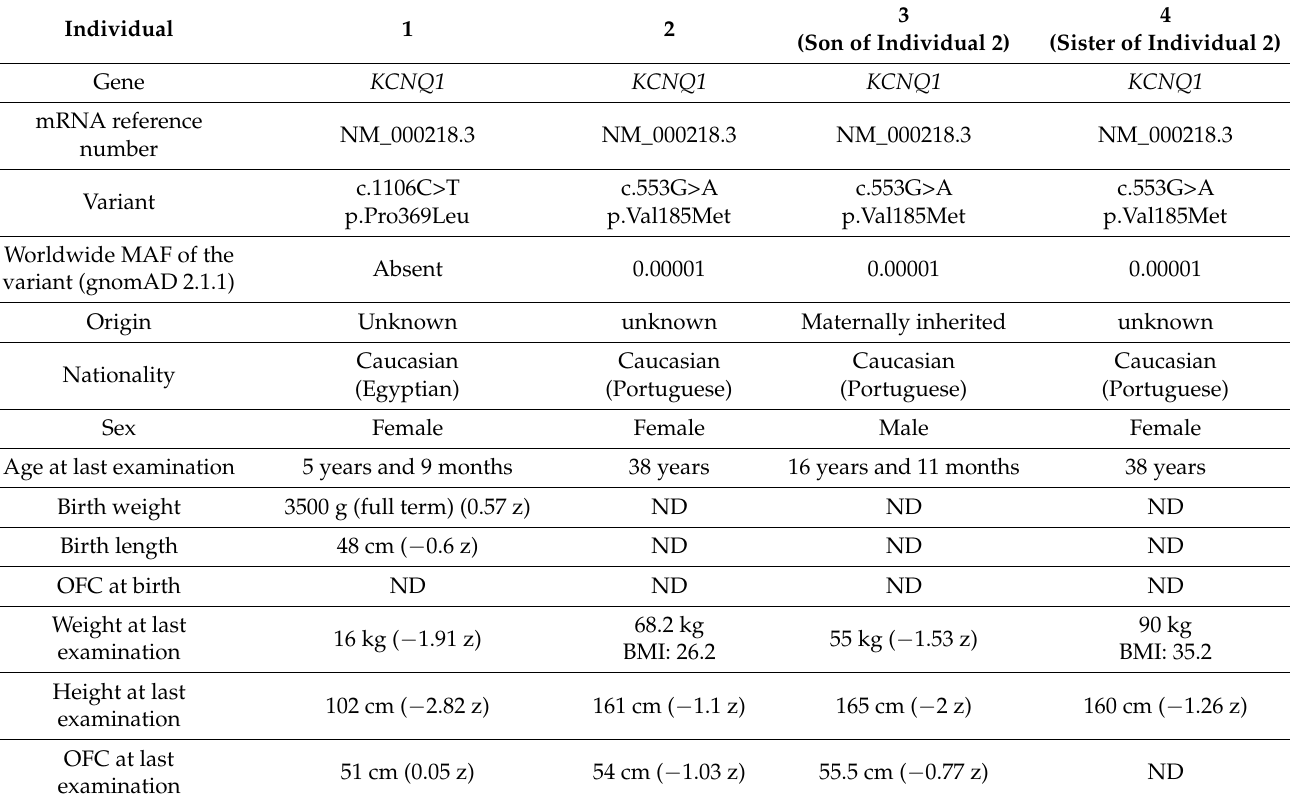
Table A1. Clinical features in individuals with a heterozygous KCNQ1 pathogenic variant identified in this